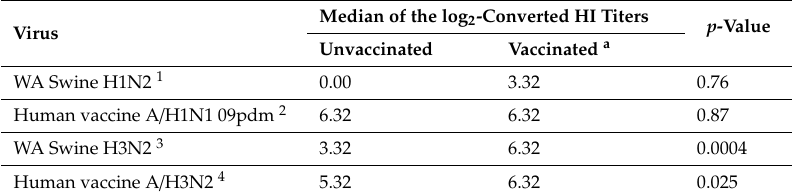
Table 2. A comparison of the mean HI values in vaccinated and unvaccinated workers using a Kruskal–Wallis test on the log 2 -transformed HI titer, where HI titers < 10 were assigned a notional value of 1. The one worker with a confirmed acute seasonal A(H3N2) infection was excluded. Median of the log 2 -Converted HI Titers p -Value Virus